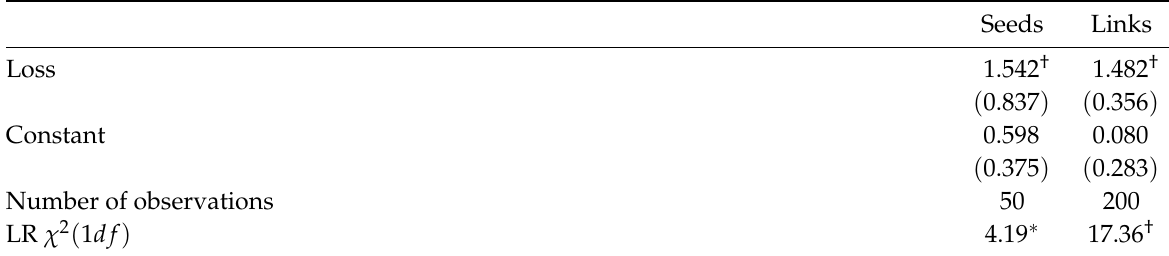
Table 1: The effect of generalized reciprocity on the amount transferred from the next